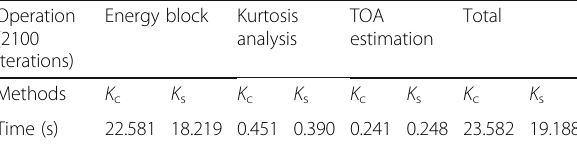
Table 3 Running time of different